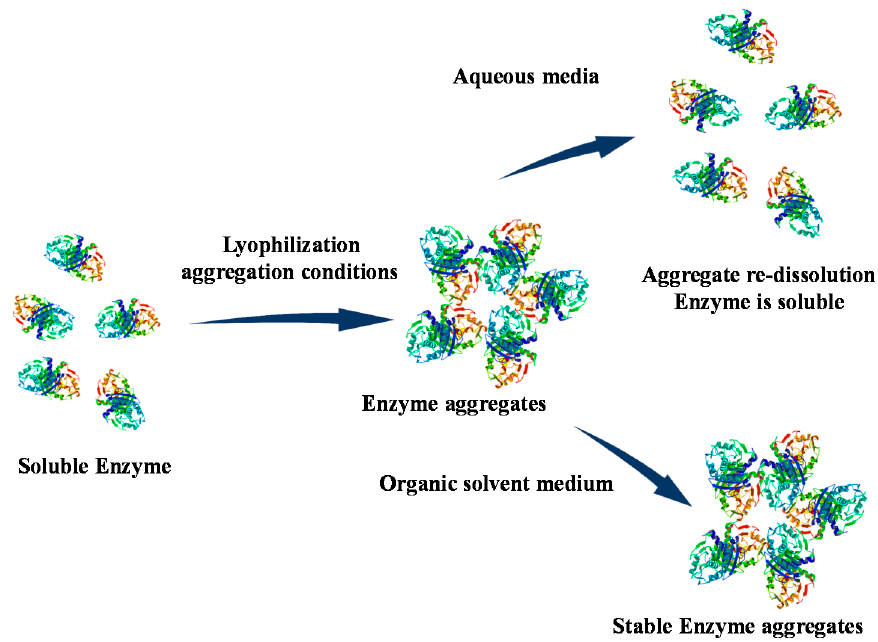
Figure 4. Schematic representation of the immobilization of enzymes using aggregates.